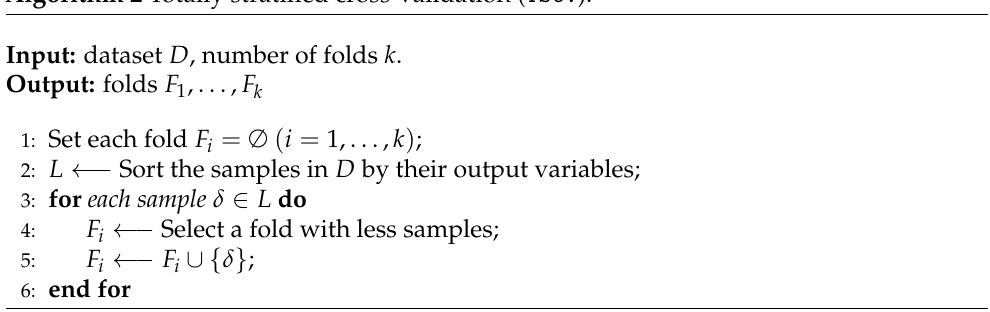
Algorithm 2 Totally stratified cross-validation ( TSCV